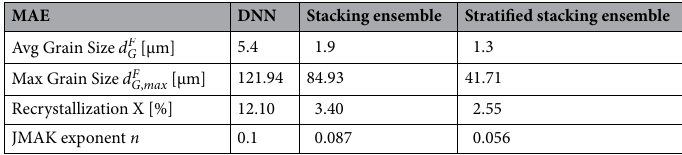
Table 1. Comparison of MAE among the three tested surrogate